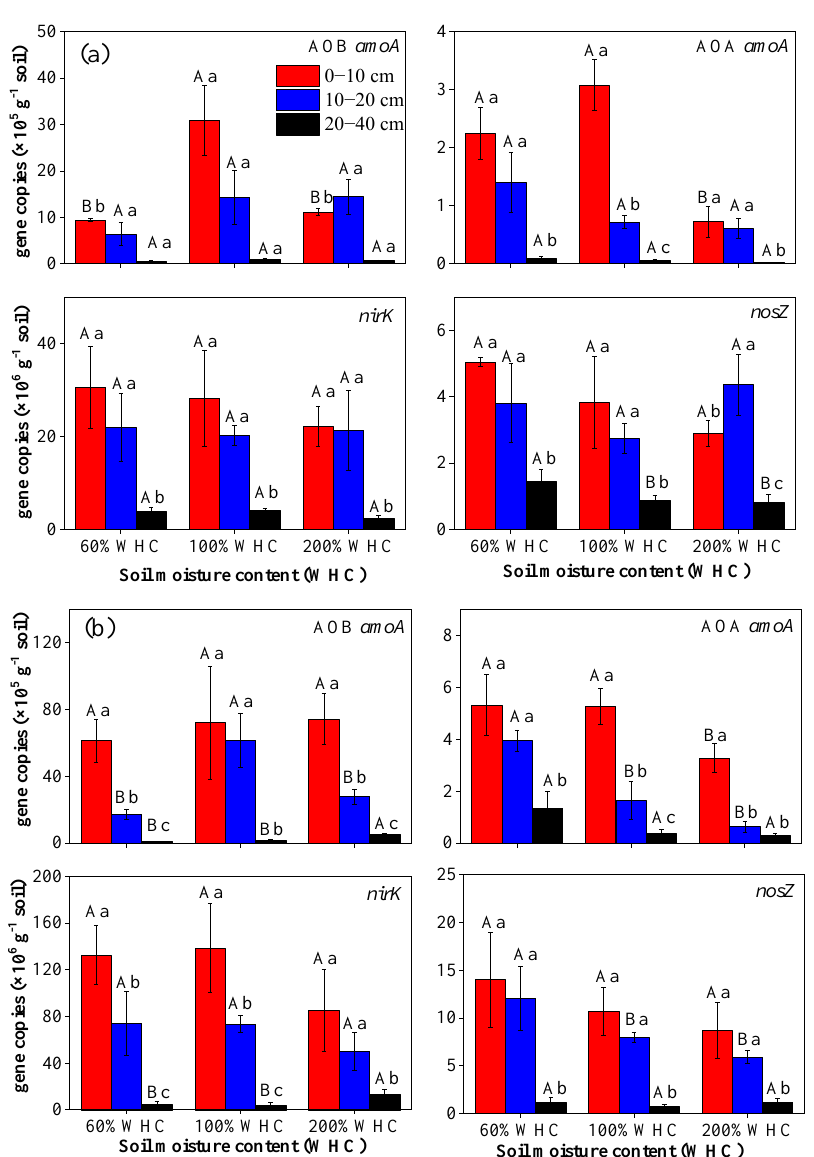
Figure 6. Effects of soil layers (0–10, 10–20, and 20–40 cm) and soil moisture (60%, 100%, and 200% WHC) on the abundance of AOA, AOB, and nirK and nosZ genes in hydromorphic ( a ) and gleyed ( b ) paddy soils after incubating for 21 days. Values are means of three replicates, and the error bars represent standard errors. Different capital letters above the columns denote significant difference between soil moisture for a given depth at p < 0.05. Different lowercase letters above the columns denote significant difference between soil depth for a given moisture at p < 0.05. Table 2. Summary for the two-way ANOVA on N 2 O emission and AOB, AOA, and nirK and nosZ gene abundance for the two factors (soil moisture and soil depth) in the two paddy soils.